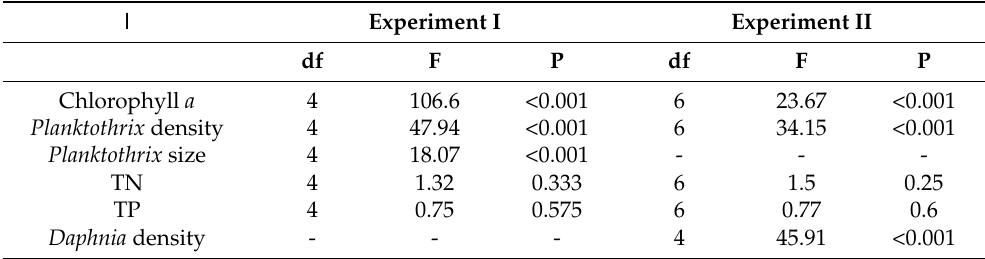
Figure 2. Mean values of chlorophyll a concentration ( ± standard error) in the different treatments corresponding to 15% PVI or 2.5 gWWL − 1 (g of wet weight per liter), 35% PVI (4 gWWL − 1 ), and 45% PVI (5 gWWL − 1 ) ( A ), Planktothrix cell per liter ( B ), Planktothrix size ( C ), and relative abundance of phytoplankton community ( D ). Table 2. Results of ANOVA analysis. Experiment I compared the chlorophyll a , Planktothrix density and size, TN, and TP based on the factors of different percentages of PVI; Experiment II compared the chlorophyll a , Planktothrix density, TN, TP, and Daphnia density based on the factors of different percentages of macrophytes, zooplankton, and fish.